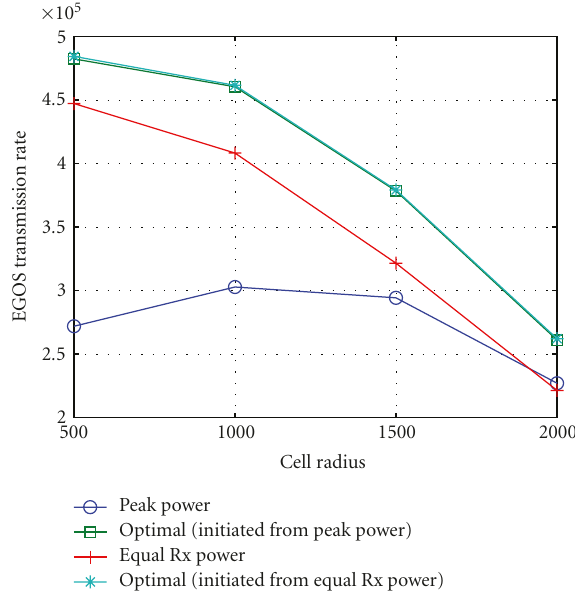
Figure 7: Asymptotic EGOS rates for di ff erent cell radiuses when w = 400kHz.